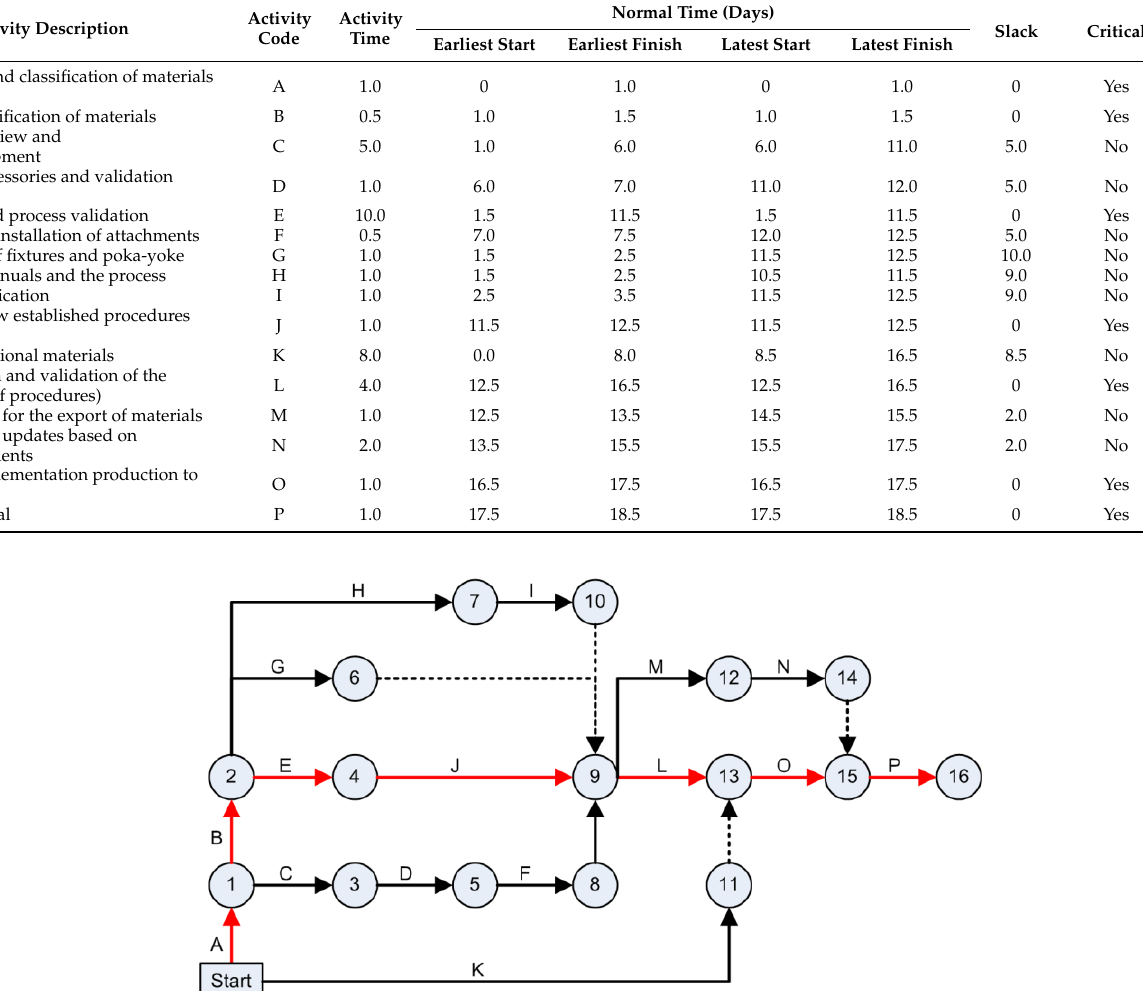
Table 2. The earliest start, earliest finish, latest start, latest finish times, and slack activities of the Reex project.